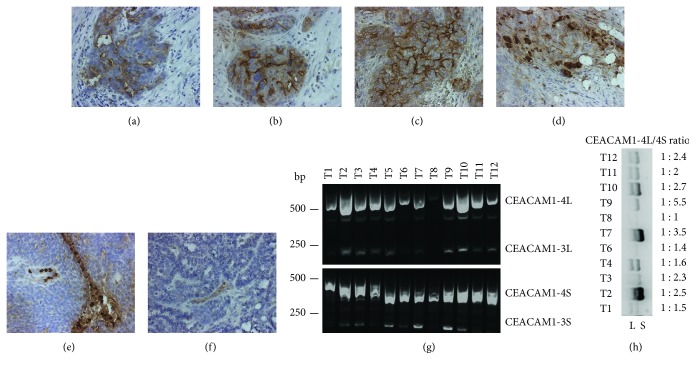
CEACAM1 protein localization and mRNA isoforms in selected ovarian tumors as detected by immunohistochemistry (a–f) and RT-PCR (g, h). CEACAM1 expression was observed in tumor cells as a mixed pattern of strong membranous staining, mainly within lumen-like structures and a weak cytoplasmic reactivity (a–c). Occasionally, a strong cytoplasmic CEACAM1 expression was observed in single cells or small cell aggregates (d). CEACAM1 staining was also found in lymphocytes (e) and endothelial cells from diverse small tumor-associated capillaries (f). RT-PCR of RNA isolated from ovarian cancer tissue using the oligonucleotides FP49 and BP60 (L-isoforms, upper panel) and FP49 and BP60 (S-isoforms, lower panel). Mainly products corresponding to the 4 (4L and 4S) isoform were amplified, whereas products corresponding to the 3 isoform were very weakly or not detected (g). A triple-primer RT-PCR was performed to quantify the expression ratios of the L and S splice isoforms. In all analyzed tumor tissues, the S isoform was expressed to a higher extent than the L isoform (h).